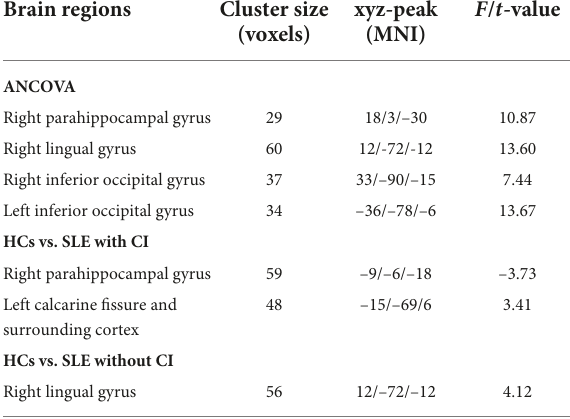
TABLE 3 Regions changes in dALFF in SLE with CI group compared with the SLE without CI and HCs groups. Brain